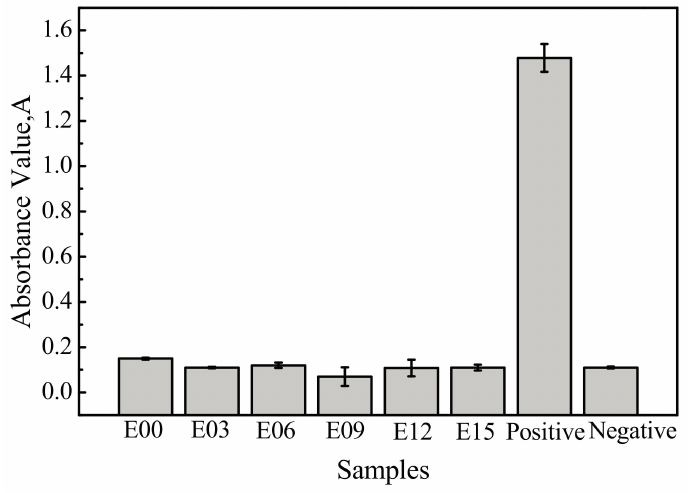
Figure 9. Absorbance value of erythrocyte on the sample surfaces. E00: substrate; E03: 3 min; E06: 6 min; E09: 9 min; E12: 12 min; and E15: 15